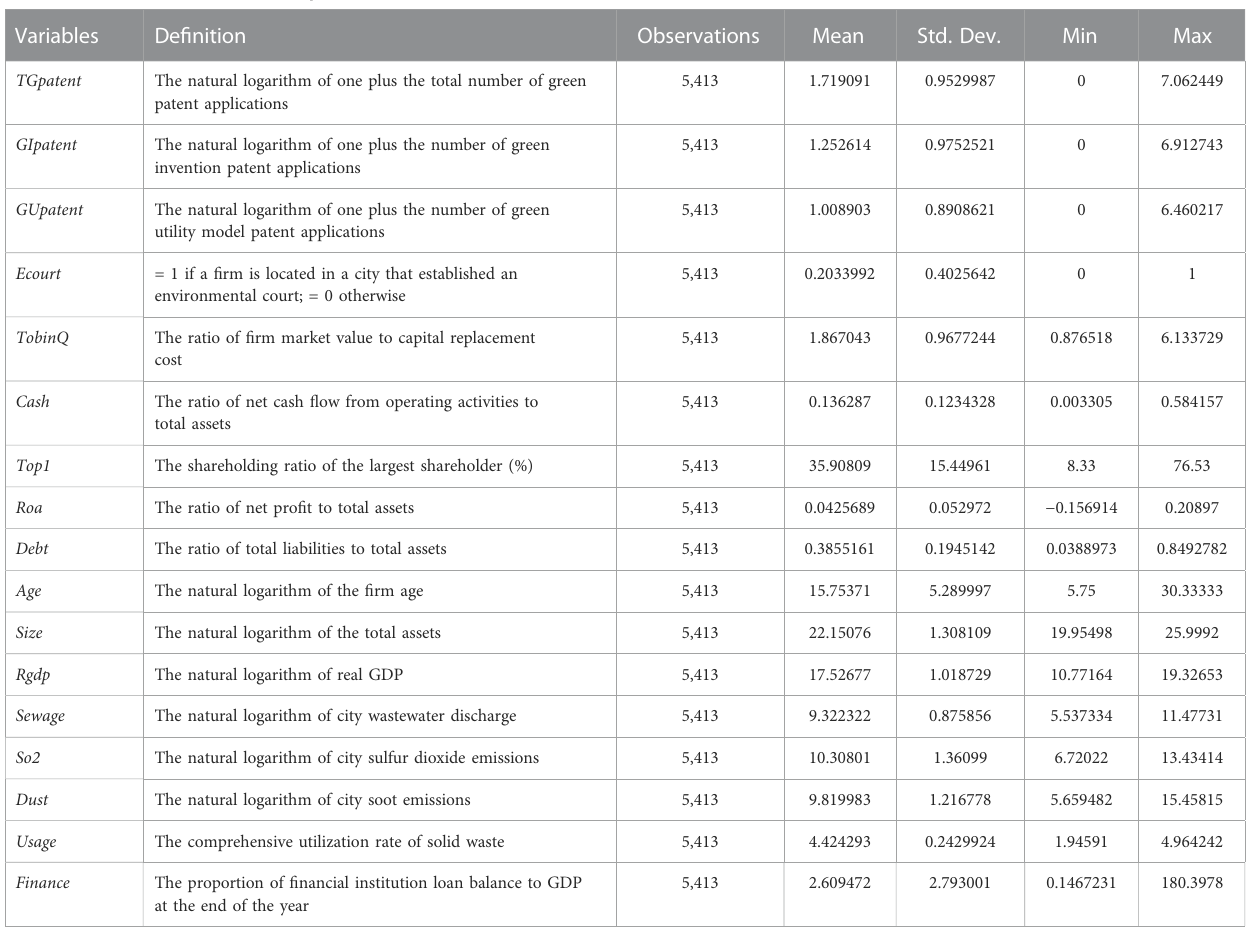
TABLE 1 Variable de fi nition and descriptive